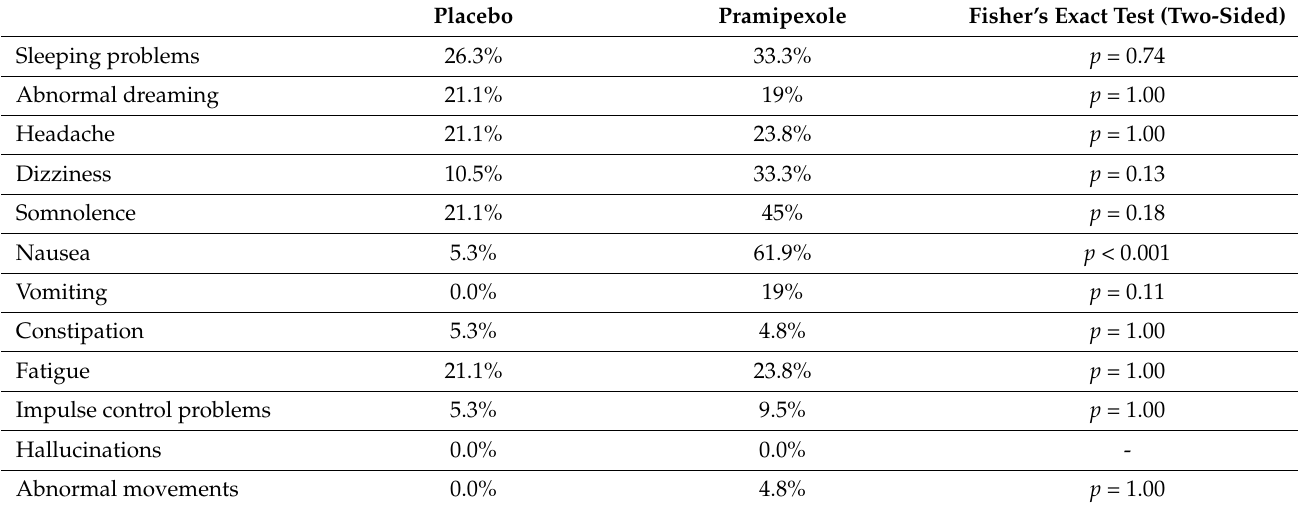
Table 2. Self-reported side effects in the placebo and in the pramipexole treatment group.